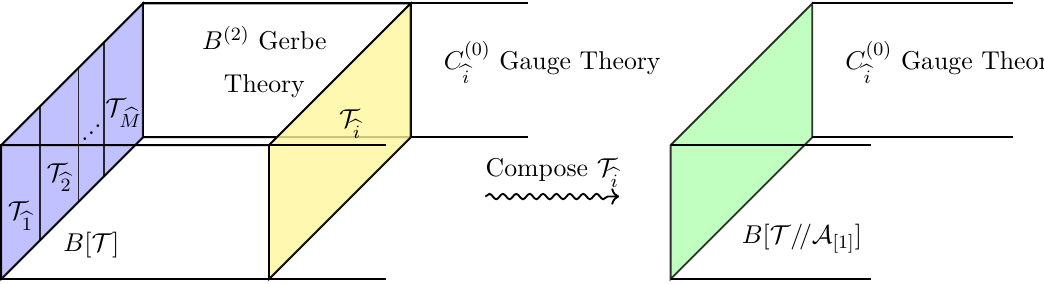
are separated b i